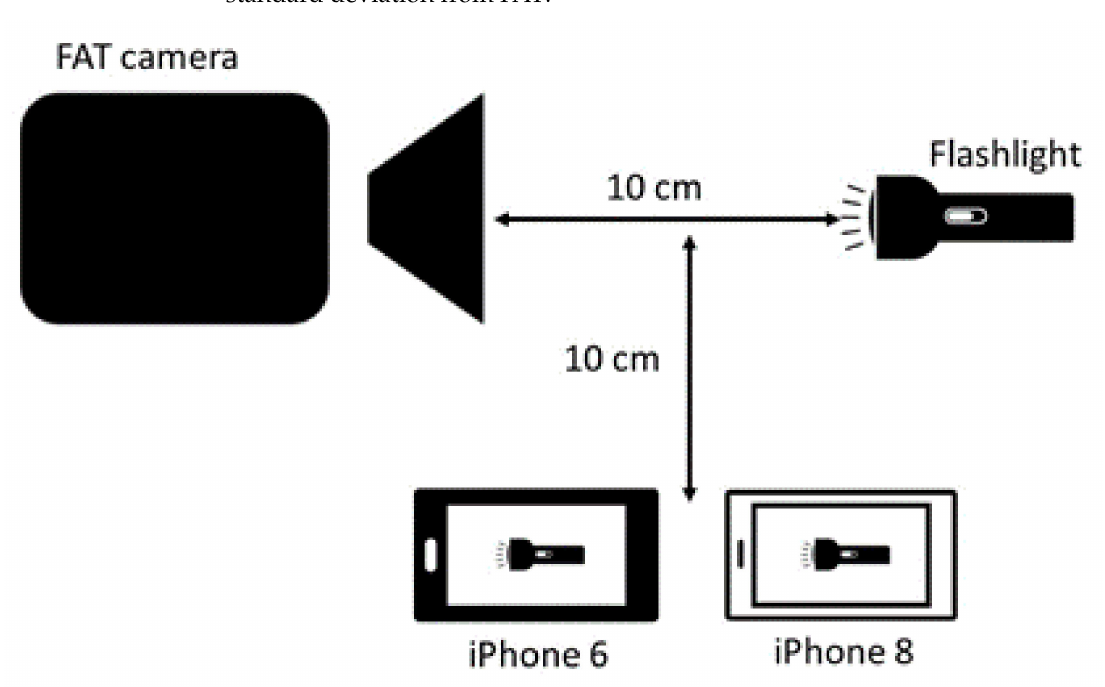
Figure 1. Set up with FAT camera, iPhones, and light source.